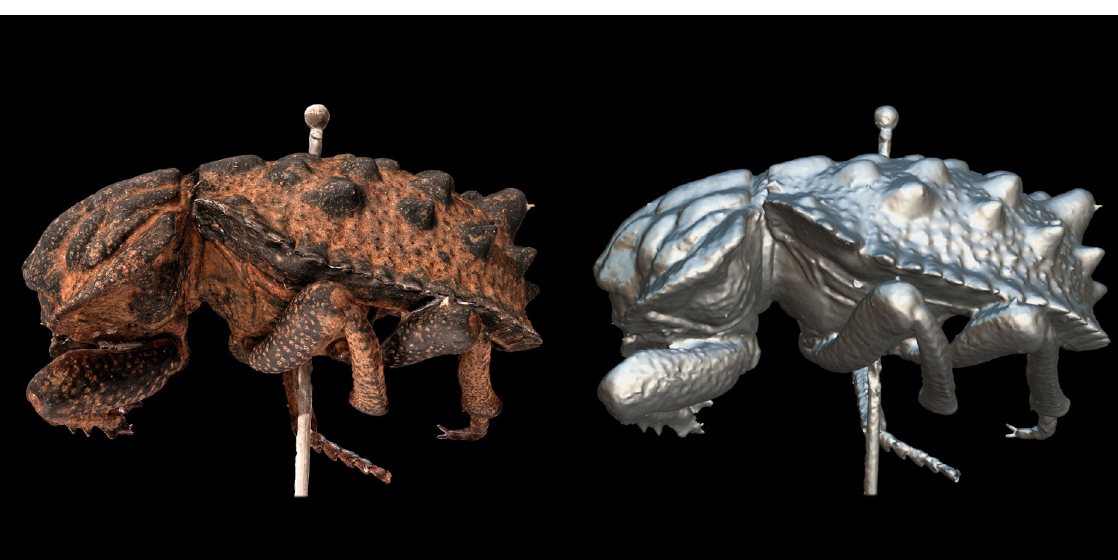
Fig. 3.21. 3D model of an Omorgus gigas by using focus stacked images and the VCM method in Agisoft Photoscan.